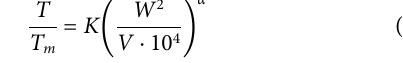
Frontiers in Materials |